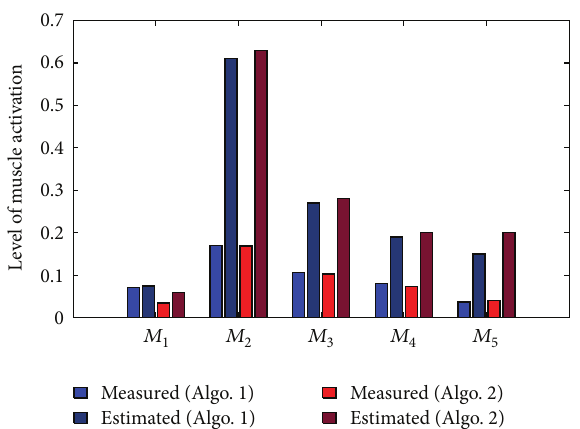
Figure 15: Level of muscle activation (Target: 𝑀 4 ).